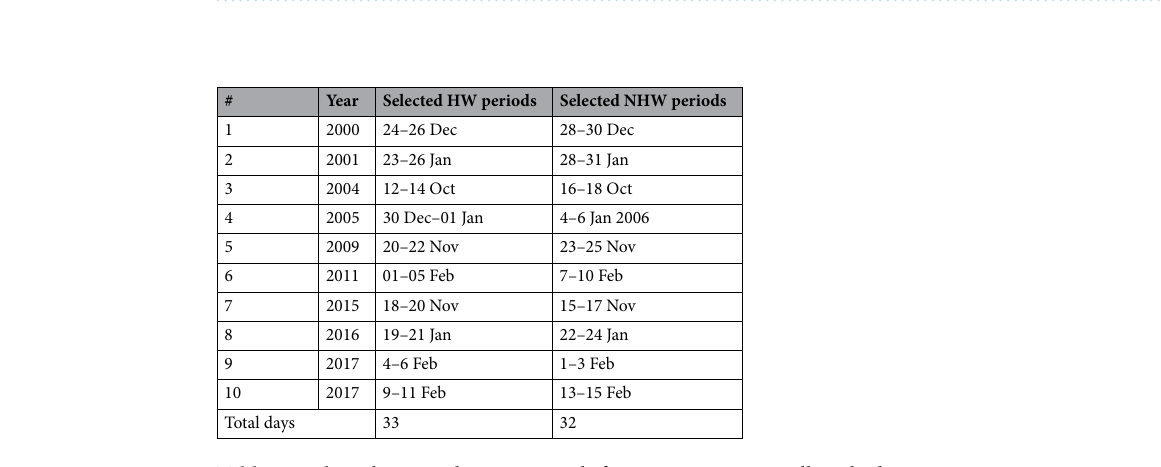
Table 3. Selected HW and NHW periods from 1999 to 2017 at all studied